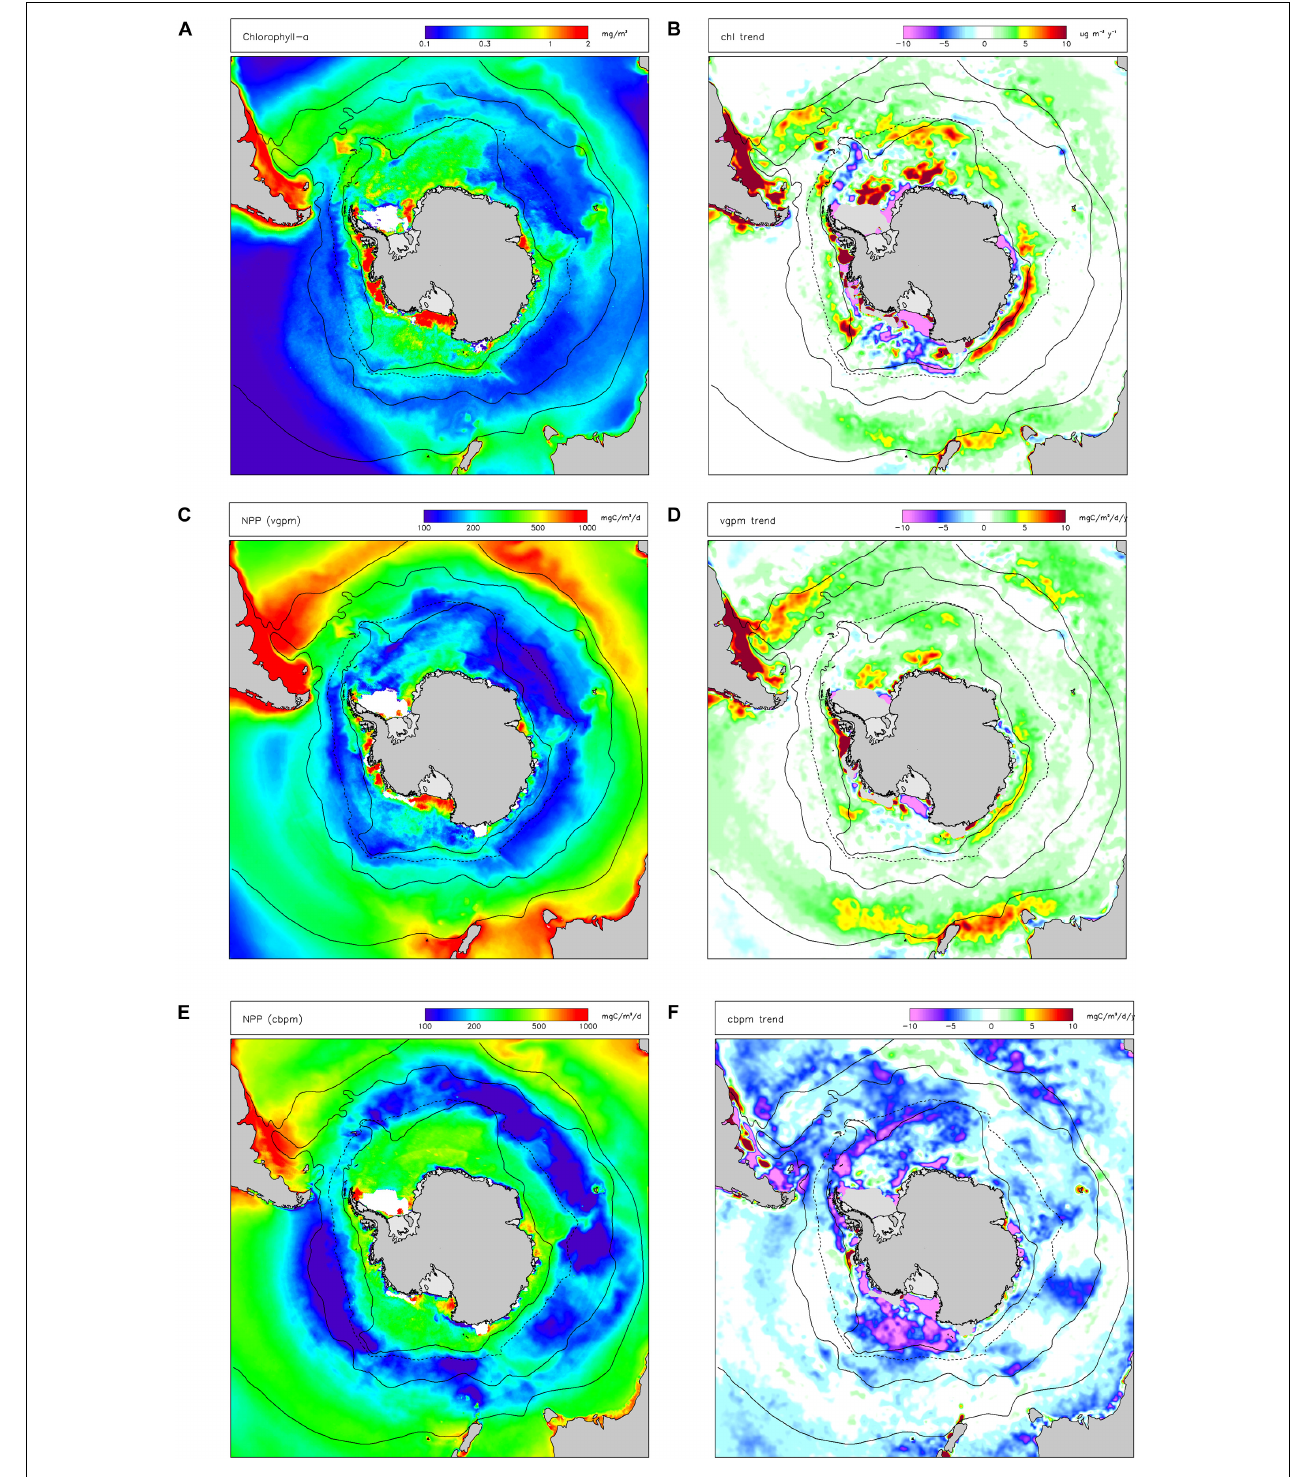
FIGURE 2 | Long-term (1997-2019) mean values of indicators for primary production: (A) chlorophyll-a concentration ( chl ); (C) net primary production in the water column estimated by the VGPM algorithm ( vgpm ) and the CBPM algorithm ( cbpm ) (E) . Linear trends (Sen slopes) over the same period are shown for (B) chl ; (D) vgpm ; (F) cbpm . White indicates missing data. Black lines are nominal positions of (from north): Subtropical Front (STF, solid line), Subantarctic Front (SAF, solid line), average maximum northern extent of seasonal sea ice (dashed line), and the Southern boundary of the Antarctic Circumpolar Current (SB-ACC, solid line).